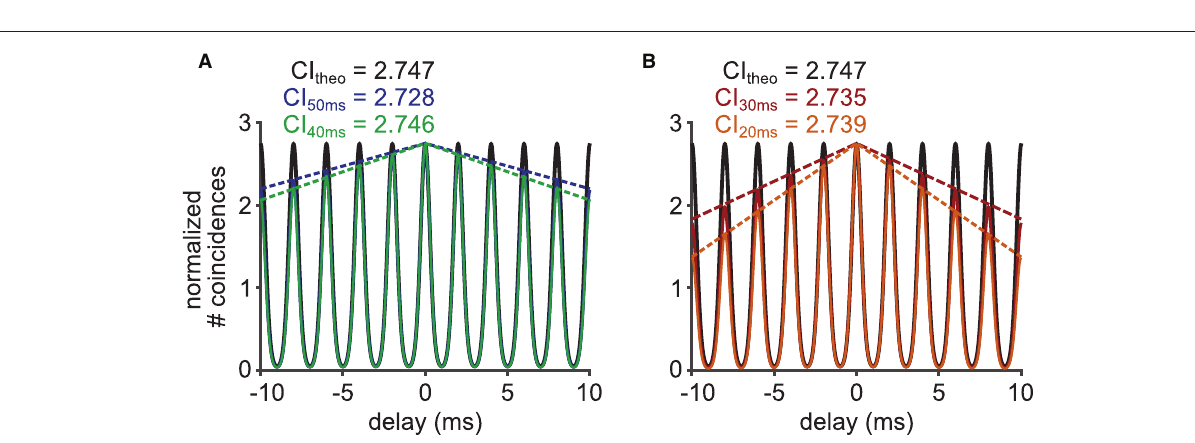
FIGURE 6 | Effects of limited data length on the heights of the side peaks of the SAC. (A) (Black) Theoretical SAC for a spike train of an infinite length for a 500 Hz stimulation. (Blue) SAC for a 50 ms long interval of a simulated spike train with theoretical decay of SAC peak heights (dotted blue). (Green) SAC for a 40 ms long interval of a simulated spike train with theoretical decay of SAC peak heights (dotted green). The concentration parameter κ was 2.8713 corresponding to a VS of 0.8. (B) More examples for different data lengths of 30 (red) and 20 (orange)